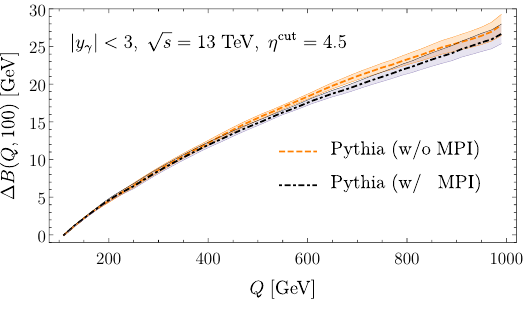
Figure 4 . The observable (cid:1) B ( Q; Q The uncertainty bands correspond to statistical uncertainty due to (cid:12)nite sample